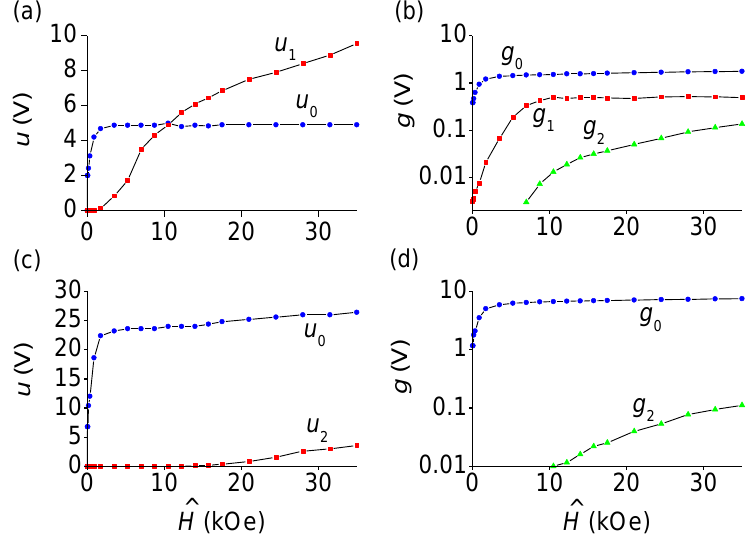
Figure 5. Dependencies of the characteristics of the generated pulse ( u characteristics of its spectrum ( g CoFe/PZT/CoFe structure (( c ) and ( d )) on the amplitude of the pulse magnetic field Ĥ . The lines connecting experimental points serve as a guide to the